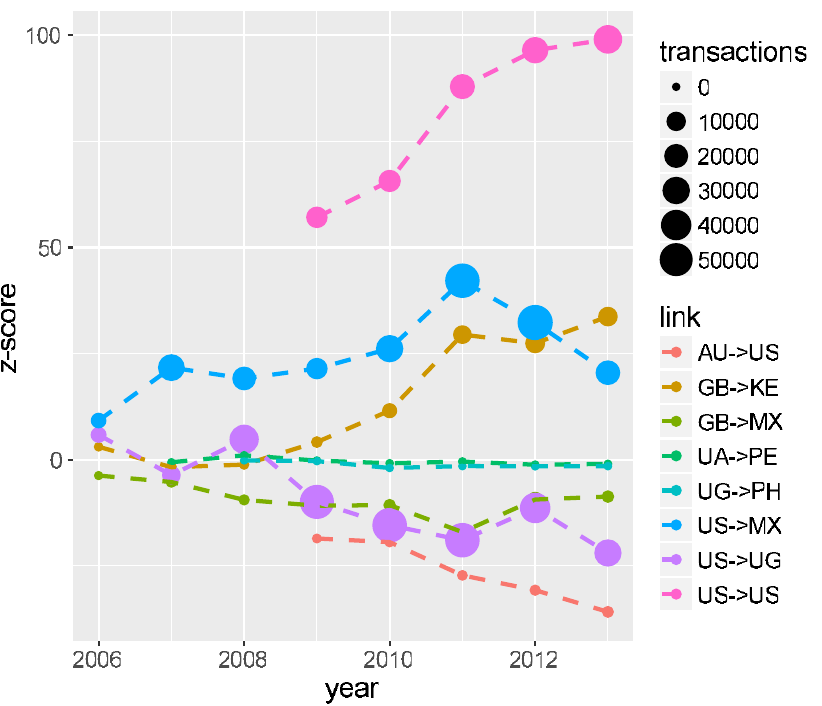
Fig 4. Evolution of link biases. Time series of link level bias measured as z-scores for select links. The size of each dot corresponds to the number of transactions across the corresponding link. Few of these links (e.g., US to MX) are consistently biased while a few are unbiased (contributing to flatness) for all